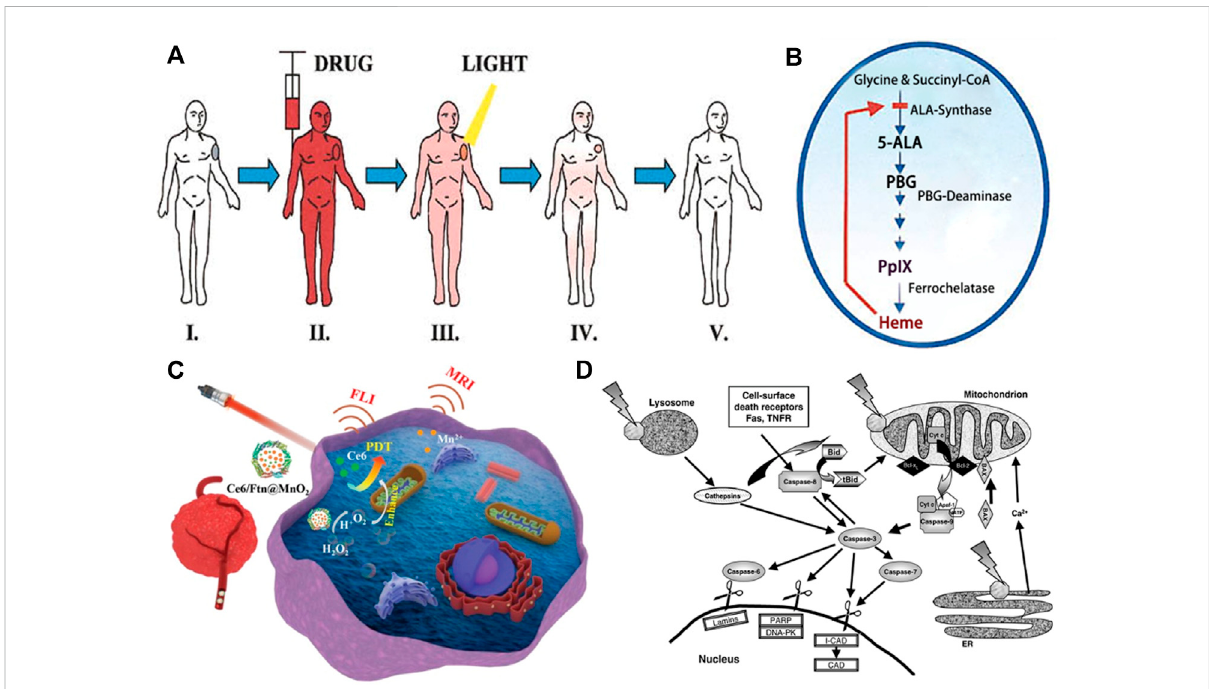
FIGURE 3 PDTtreatmentfortumorinthe fi eldofPRS. (A) PDTtreatmentprocedure.StepI:PatientwithtumorbeforePDT.StepsII-III:Thephotosensitizer istakenupbymosttissues,butitisretainedlongerinthetumor.Themalignantlesionisirradiatedselectivelyatthemaximaltumor-to-normal-tissue drug ratio. Step IV: The photosensitizer clears gradually from all tissues while the tumor starts to shrink as a result of PDT-mediated tumor cell destruction. Step V: Complete tumor ablation and clearance of photosensitizer from Kalka et al. (2000). (B) Porphyrin metabolism under physiologic conditions in tumor cells during ALA-based PDT from Kalka et al. (2000). (C) Schematic illustration of Ce6/Ftn@MnO 2 used for FLI and MRI bimodal imaging-guided hypoxic malignant tumor therapy from Zhu et al. (2022) (D) Some PDT-associated apoptosis pathways involving plasma membrane death receptors, mitochondria, lysosomes and ER, caspases and Bcl-2 family proteins. Most photosensitizers for PDT bind to mitochondria, lysosomes and/or other intracellular membranes, including the ER from Oleinick et al.